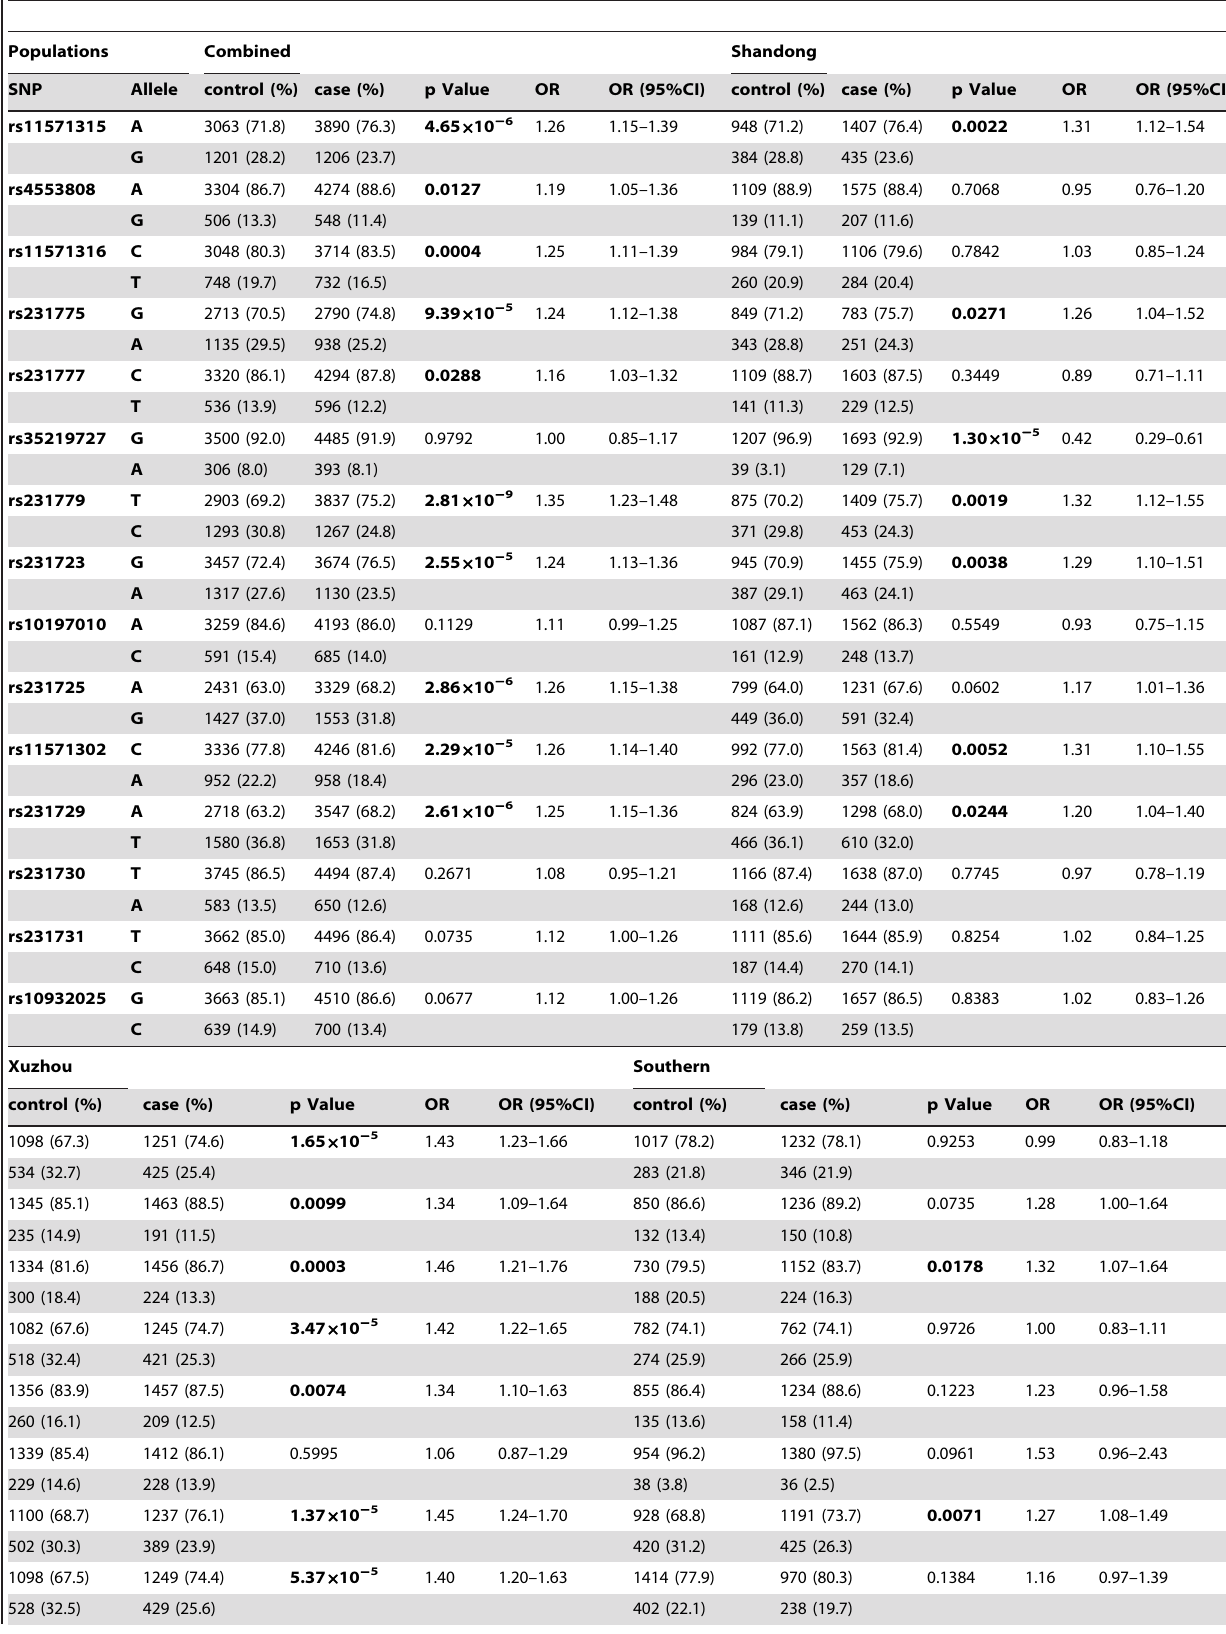
Table 1. Allele frequencies in GD and control subjects for SNPs in the CTLA4 gene region in different populations.